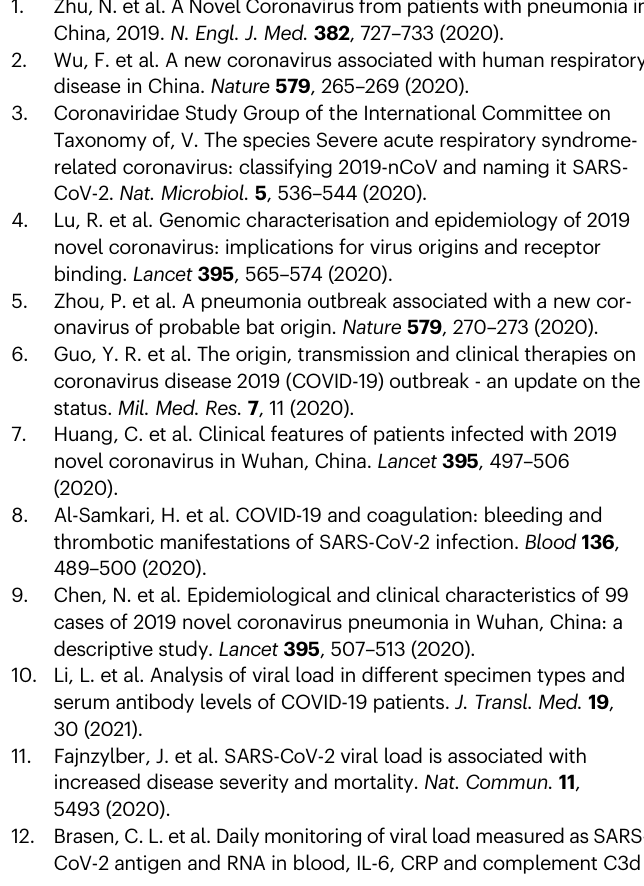
Fig. 2A – B were compared over a whole grid. The particles shown in Fig. 4I originate from the tomogram used for the membrane curvature analysis. The immunoblots in Supplementary Fig. 1D was performed using platelets from three different donors. S-protein pseudotyped viral particles were checked for their morphology on three different grids using negative stain. The S-protein pseudotyped viral particle in cryo-EM was observed for one